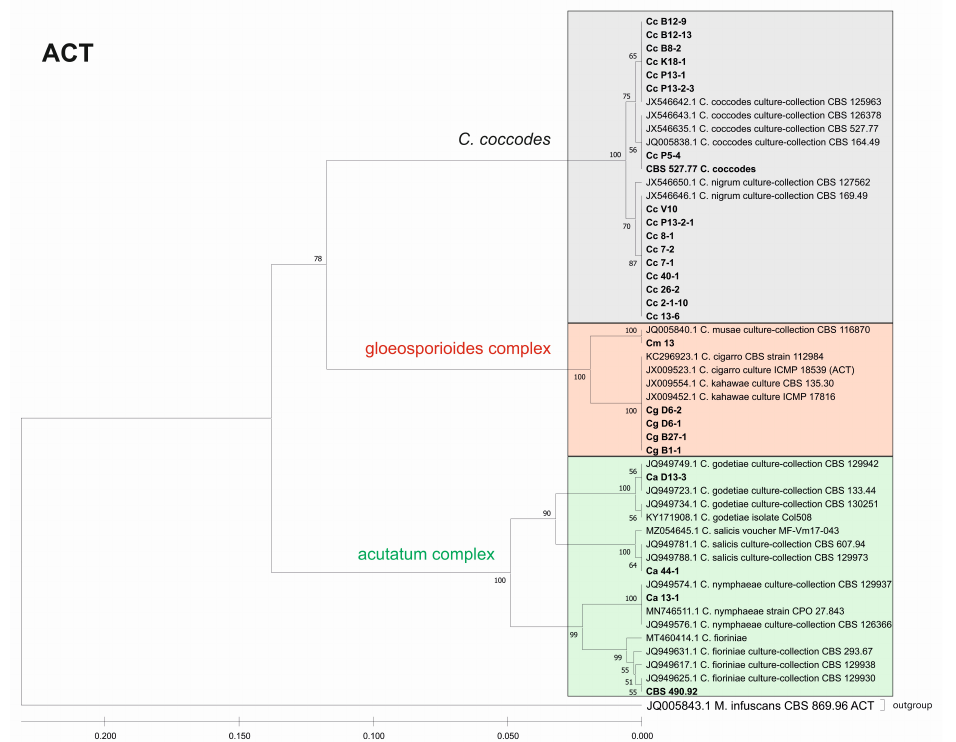
Figure 7. Phylogenetic tree based on ACT barcode. Genetic diversity and taxonomic assignment of the studied Colletotrichum isolates against accessions in the NCBI database and assessed by DNA barcode for the actin (ACT) locus. The Colletotrichum clades coccodes, gloeosporioides, and acutatum are depicted by grey, red, and green boxes, respectively. The trees were constructed in MEGA11 using the UPGMA clustering method and the Kimura 2-parameter model. The percentage of replicate trees in which the associated taxa clustered together in the bootstrap test (500 replicates) is shown next to the branches. The tree is drawn to scale, with branch lengths in the same units as those of the evolutionary distances used to infer the phylogenetic tree. All ambiguous positions were removed for each sequence pair (pairwise deletion option). Sequences derived from the NCBI are shown with their accession number and organism